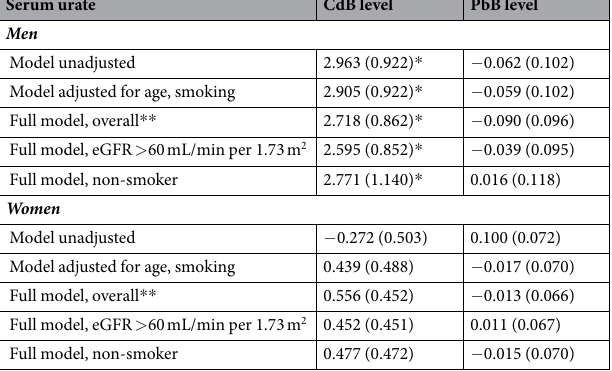
Table 2. Association of CdB level (independent variable) with serum urate level (dependent variable). Data are expressed as unstandardized coefficients (standard errors). Linear regression analyses were used. eGFR, estimated glomerular filtration rate. * Denotes statistical significance at P < 0.05. ** Full model included PbB, eGFR (which incorporates age and serum creatinine level), current smoking status, diabetes, dyslipidemia, hypertension and BMI. All variables were categorical except eGFR and BMI, which were entered as continuous